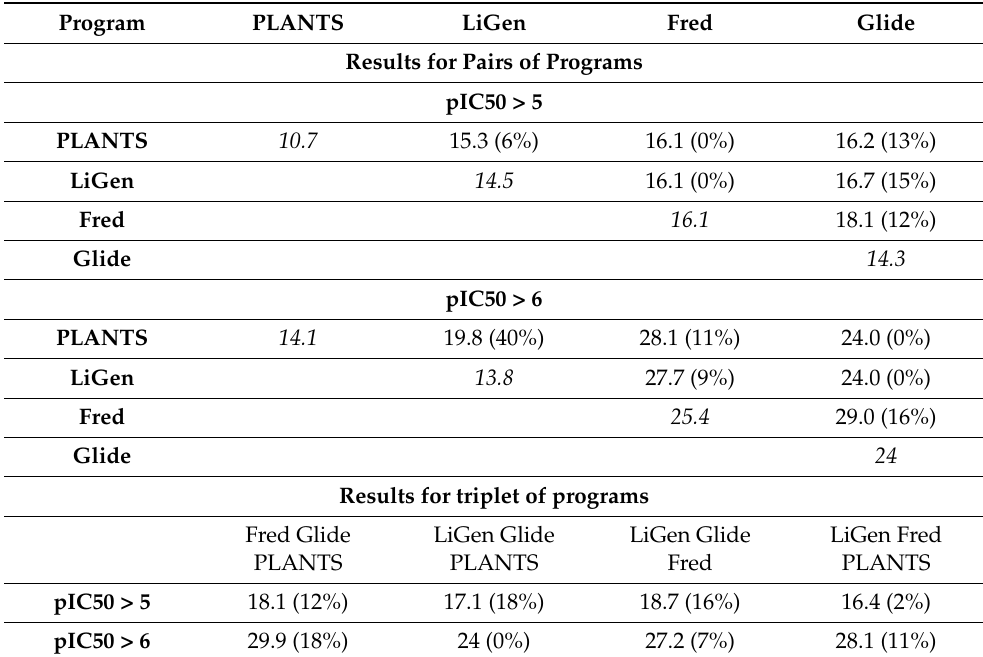
Table 6. Best EF1% values as obtained by combining the simple score values (without space pa- rameters) of two or three different docking programs and the corresponding synergistic effect (as enhancements in percentage values). For easy comparison and concerning the results for pairs of docking tools, the diagonal cells reports the best EF1 value obtained by the single docking tool (in